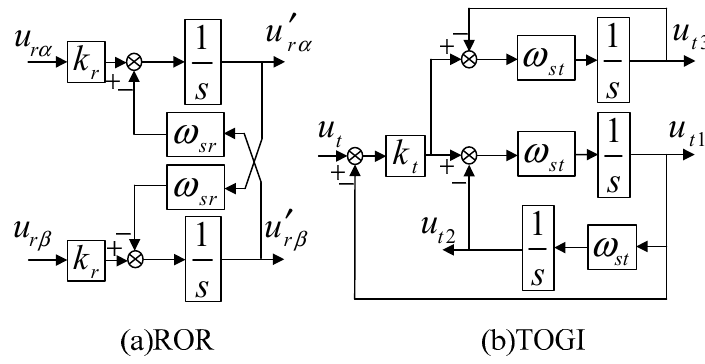
Figure 4. Block diagram of ROR regulator /TOGI.